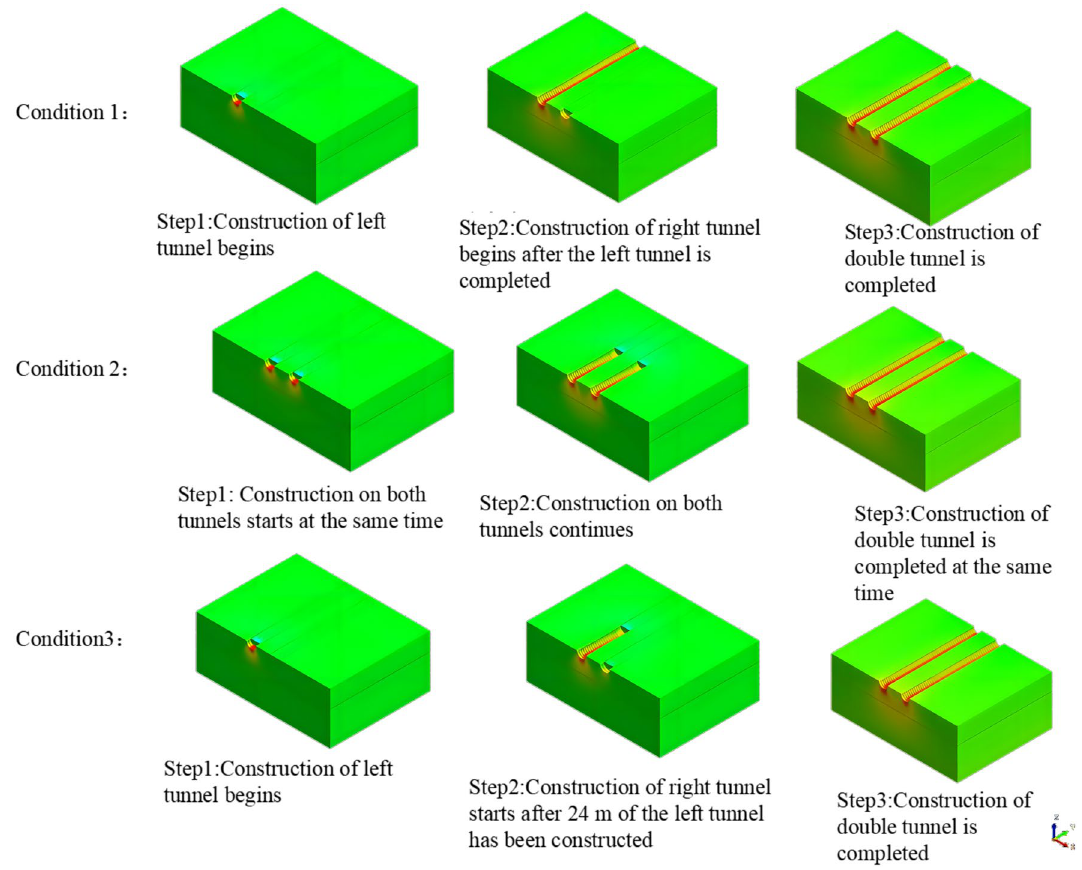
Figure 8. Construction sequence diagram of the three working conditions.